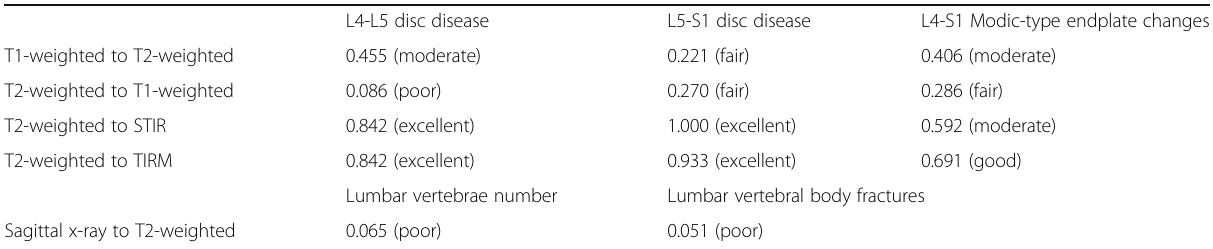
Table 2 Concordance (expressed as κ -value) between the native images and those generated with virtual multimodal imaging